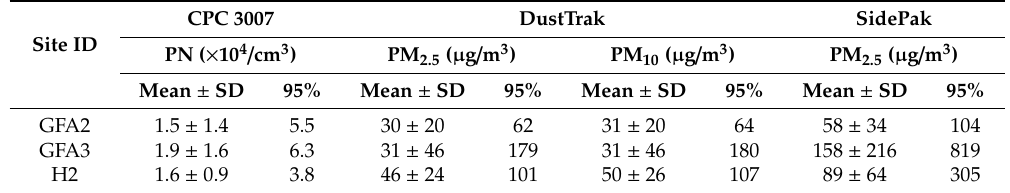
Table 5. Indoor particle number and mass concentrations (mean ± SD and 95%) during the summer campaign.